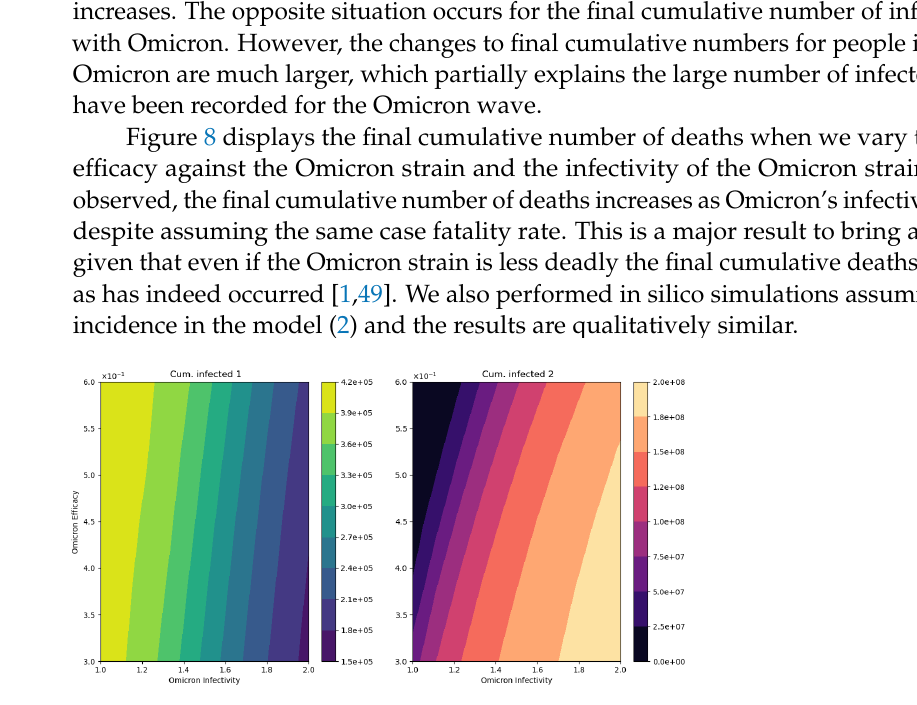
Figure 7. In silico simulation of the Omicron wave model (2). The outcomes regarding the final cumulative infected people for each strain. As the Omicron infectivity rate increases, the final cumulative number of people infected with Omicron increases but the final cumulative number of people infected with the previously circulating strain decreases.